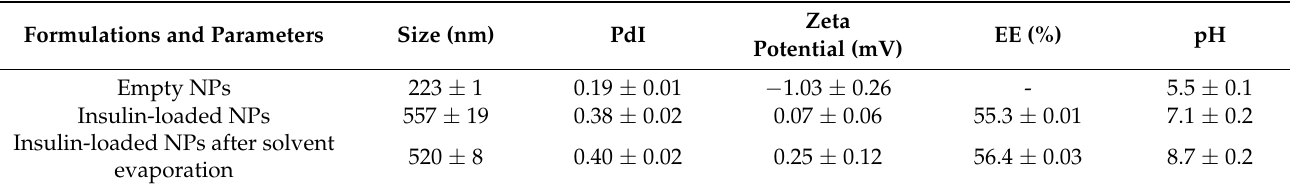
Table 1. Characterization of insulin-loaded poly-DL-lactide/glycolide (PLGA) NPs and empty PLGA NPs. All data are presented as mean ± SD (at least n = 3). NPs means nanoparticles. Formulations and